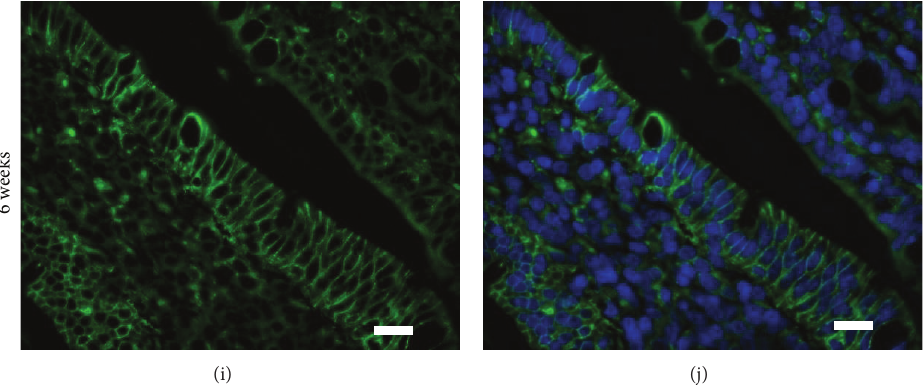
Figure 3: Claudin-4 surface localization does not change over time in piglet ileum. Claudin-4 is highly expressed on the surface of ileal intestinal enterocytes with the highest expression on the surfaces between adjacent cells at 24 hours of age ((a), (b)), 48 hours of age ((c), (d)), 3 days of age ((e), (f)), 5 days of age ((g), (h)), and 6 weeks of age ((i), (j)). These images are representatives of IHC performed on tissue from 3 animals per time point. Primary antibody: rabbit anti-Claudin-4. Secondary antibody: FITC-labeled goat anti-rabbit (green). Nuclear stain: DAPI (blue). Scale bar represents 40 𝜇